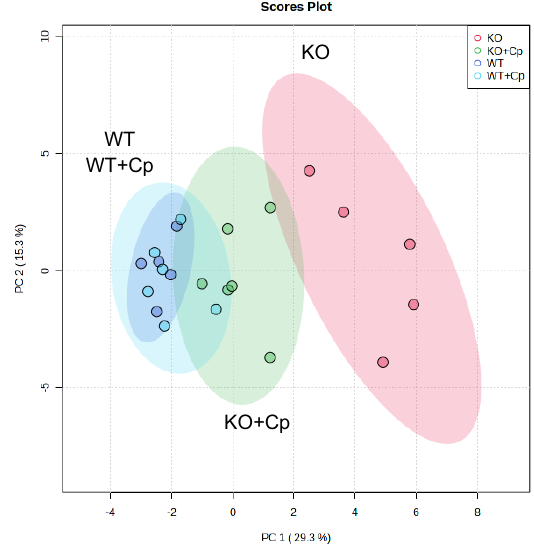
Figure 8. Unsupervised multivariate analysis of measured parameters distinguishes CpKO from WT mice and highlight the role of administered Cp in ameliorating the iron/lipid dysmetabolism. Principal component analysis (PCA) of 28 parameters measured in liver and pgAT. For features see Supplementary Materials Table S1. Each dot represents one animal (CpKO = red; WT = blue; CpKO+Cp = green; WT+Cp = cyan); ellipses represent the 95% confidence interval area of each group.